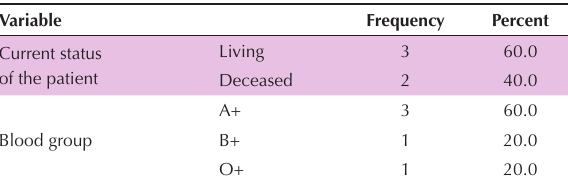
Table 3. Frequency of lymphocele in transplanted kidney type and frequency of blood group in patients with symptomatic lymphocele Variable Frequency